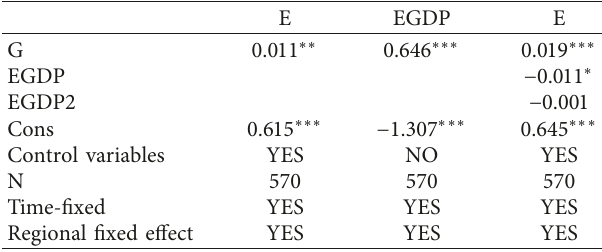
Table 9: Mediating